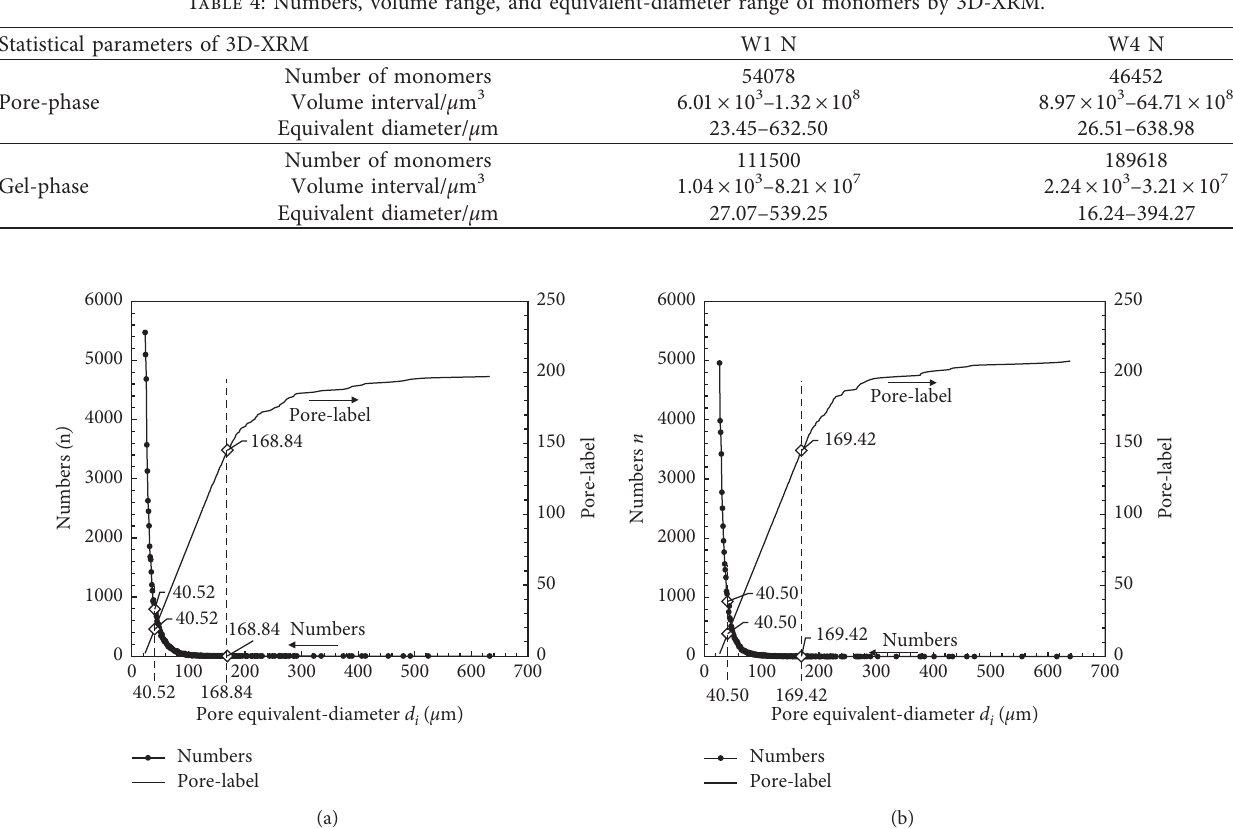
Figure 21: Quantity and continuity distribution of pore-phase of NCG concretion by 3D-XRM. (a) W1 N. (b) W4